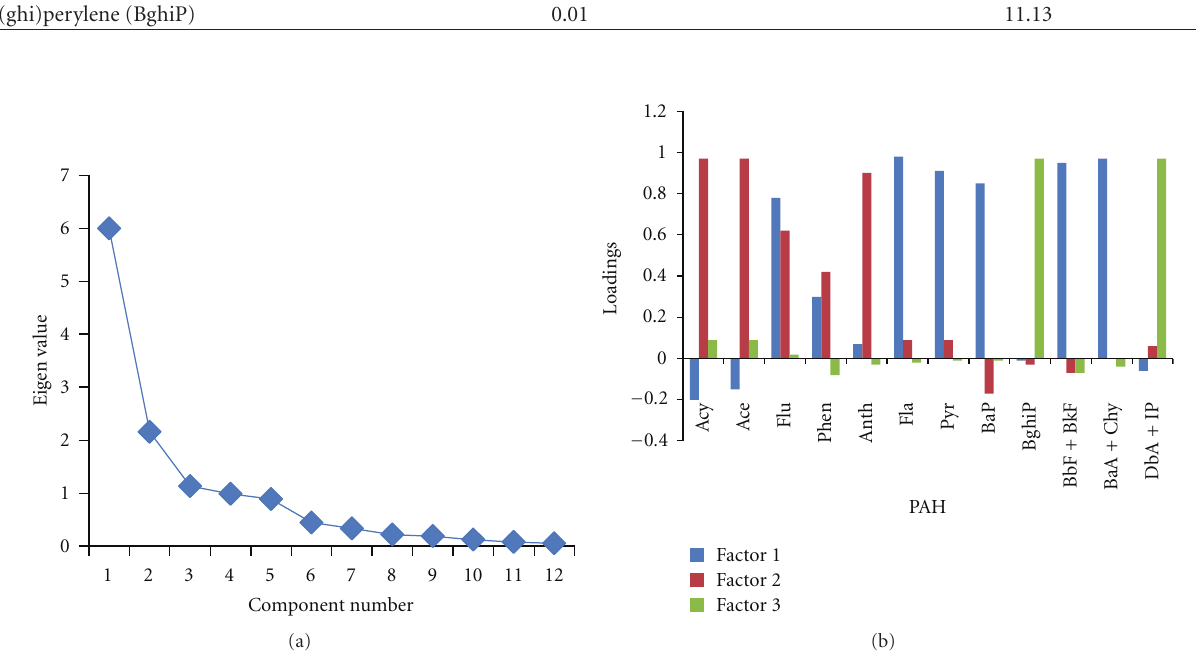
Figure 1: (a) Scree plot. (b) Factor